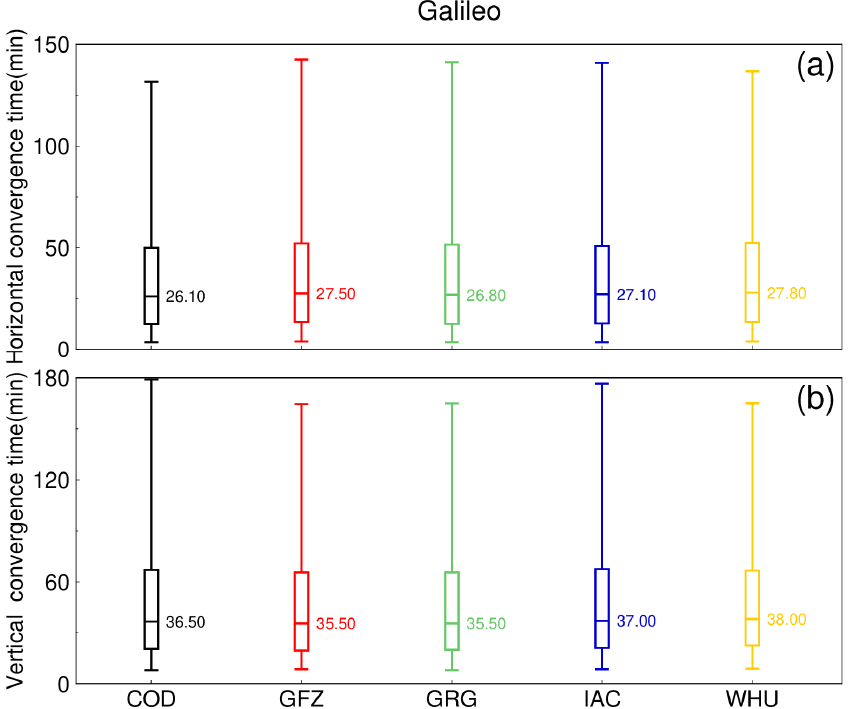
Figure 15. Distribution of the convergence time of the Galileo kinematic PPP solutions with five types of precise products for the 143 MGEX tracking stations in September 2022. ( a ) Horizontal component, ( b ) Vertical